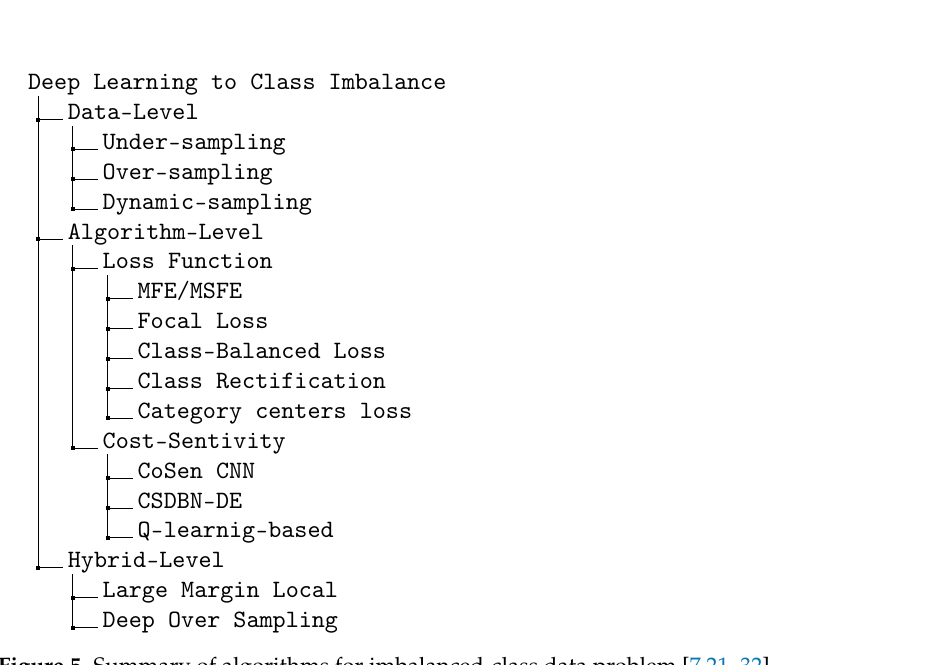
Figure 5. Summary of algorithms for imbalanced-class data problem